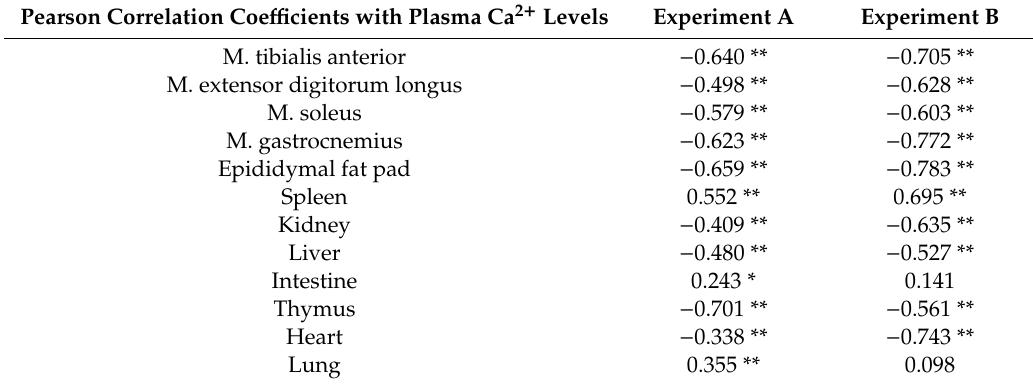
Table 2. Correlation of plasma calcium levels and muscle function of Experiment B (total product vs. controls). *, ** and # represent significant Pearson correlation coe ffi cient intervals of parameters of EDL muscle function at the frequencies 83 till 167 Hz (* = p < 0.05 and ** = p < 0.01 for all frequencies measured; and # = p < 0.01 for the frequencies ≥ 100 Hz). Pearson Correlation Coefficients with Plasma Ca 2+ Levels